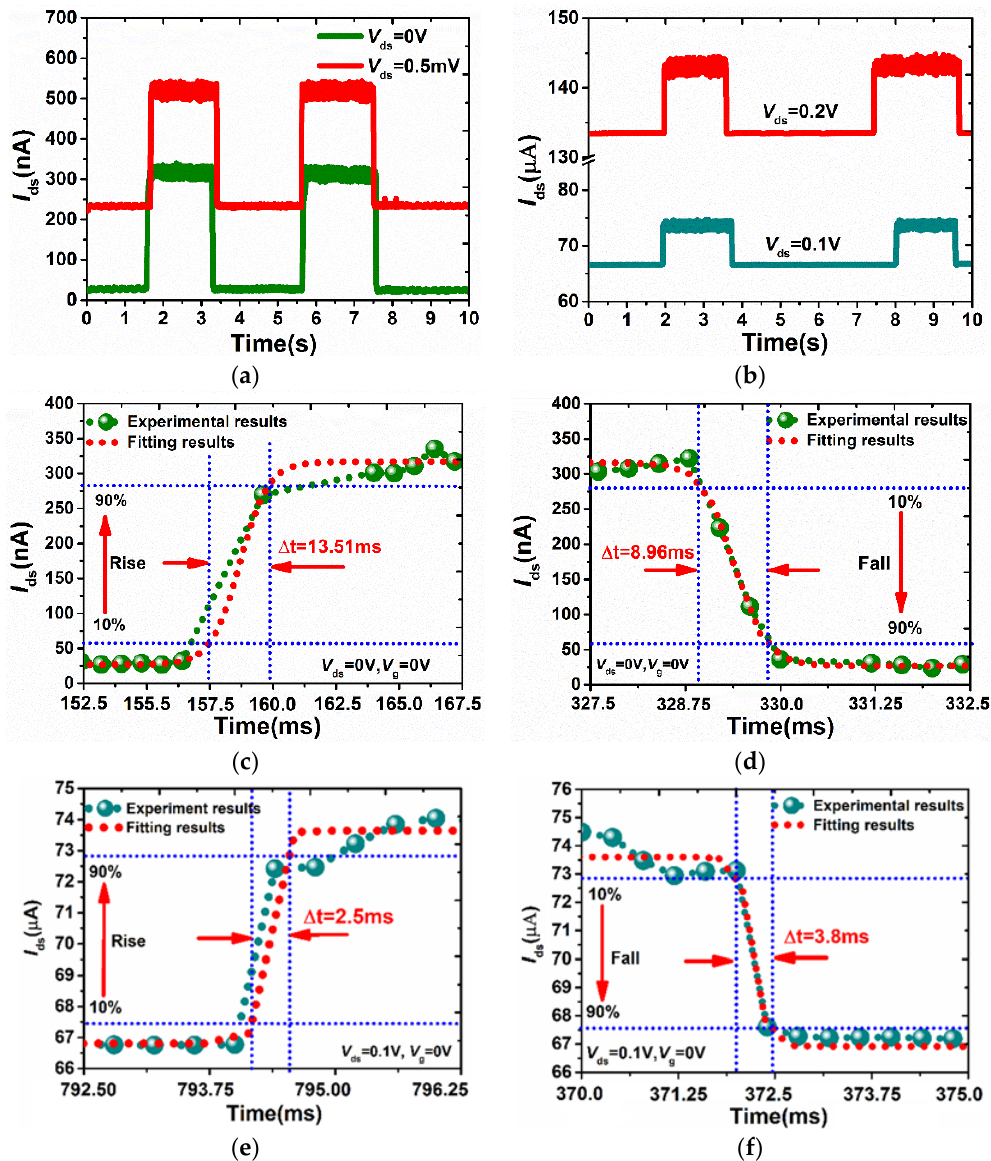
Figure 5. ( a , b )The photo ‐ switching performance under different bias voltages. ( c )The rise process and ( d ) the fall process under V ds = 0 V, V g = 0 V, P in = 10.6 μ W. ( e ) The rise process and ( f ) The fall process under V ds = 0.1 V, V g = 0 V, P in = 10.6 μ W.